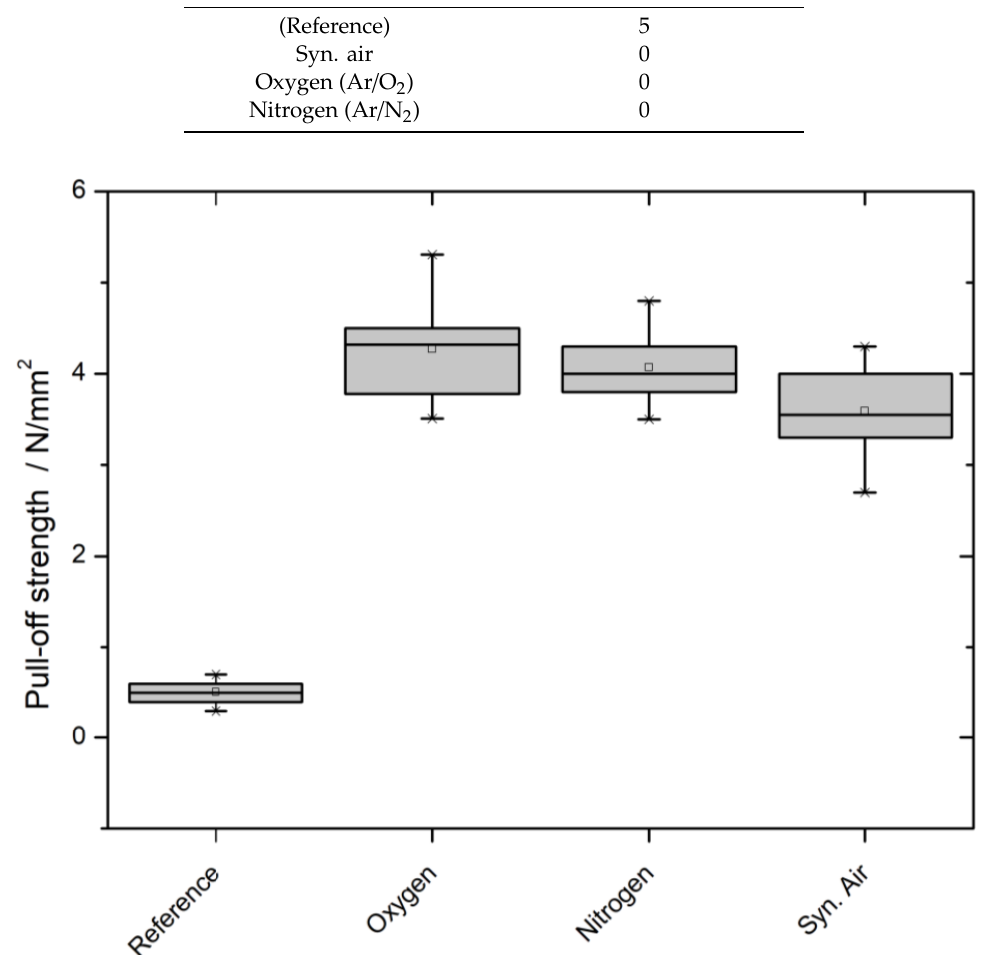
Figure 6. Pull-off strength of an acrylic dispersion measured according to ASTM D4541-02 (2009) and DIN EN ISO 4624 (2016) of PP60 before and after plasma treatment.